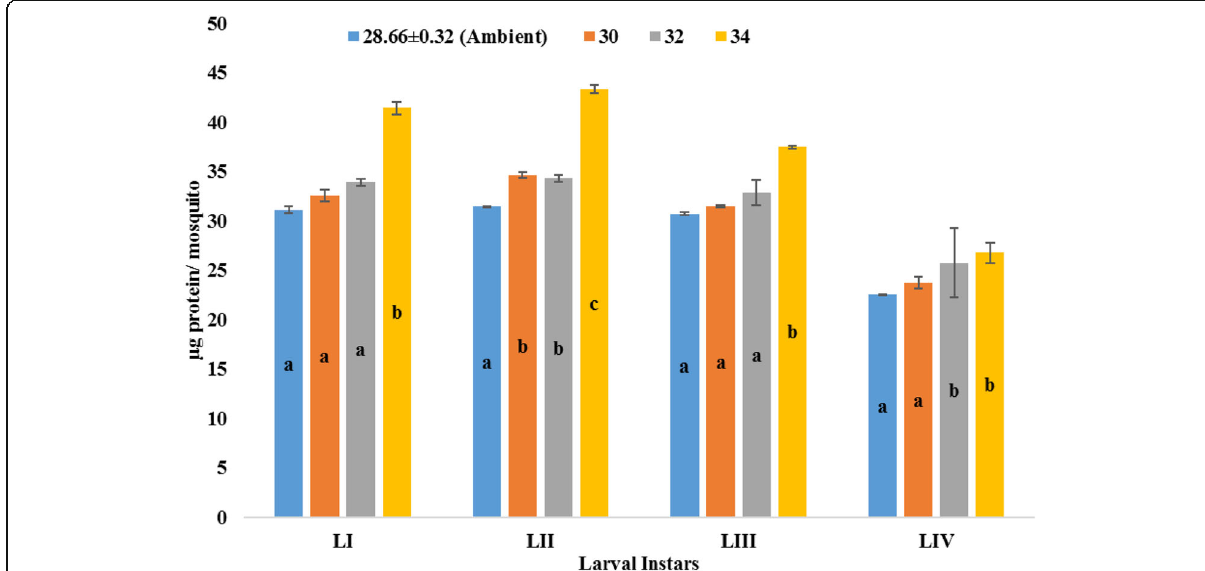
Fig. 7 Effects of rearing-water temperature on teneral protein accumulation across larval instars (LI – IV) of Culex quinquefasciatus mosquito. Temperature bars with same letter at each larval instar are not significantly different at p <0.05 according to analysis of variance. Values are expressed as mean±SD